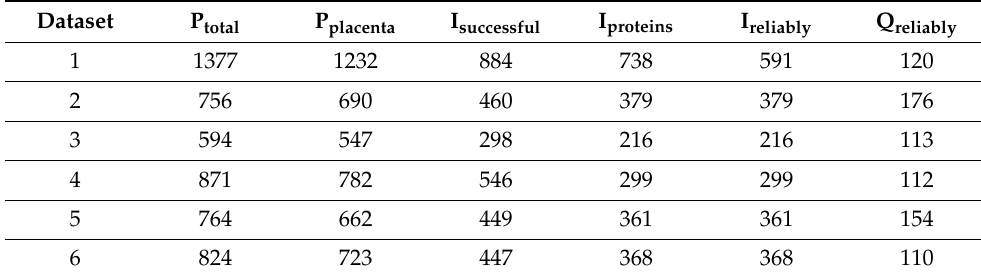
Table 2. Changes in the number of proteins identified/quantified in each dataset during data